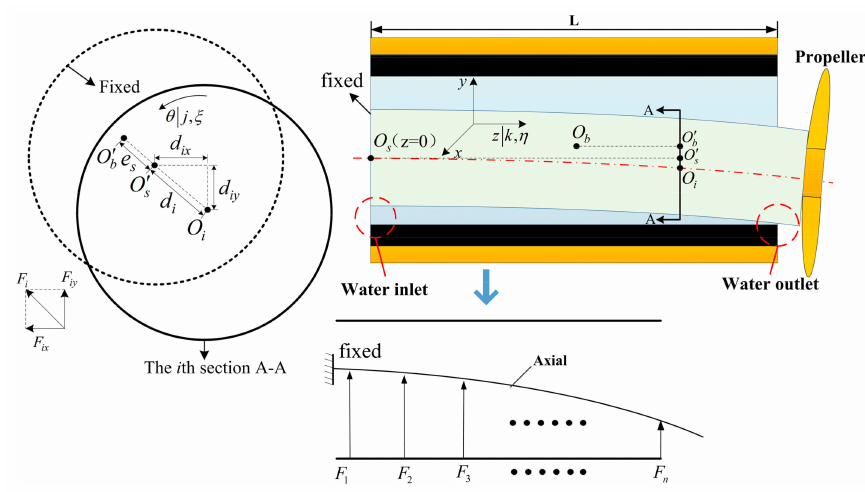
Figure 3. Schematic for the calculation of the deflection of the propeller